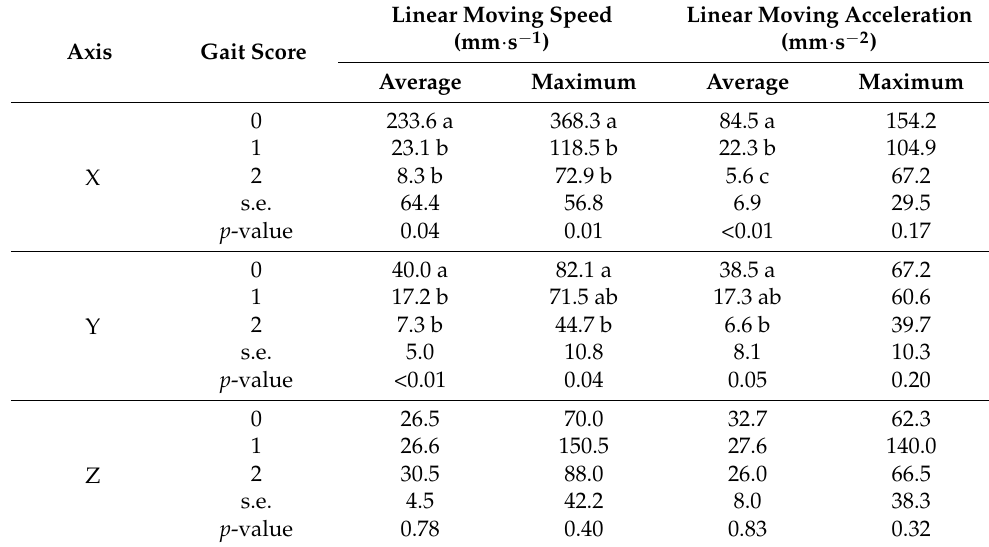
Table 1. Linear moving speed and acceleration for broilers with three gait scores.